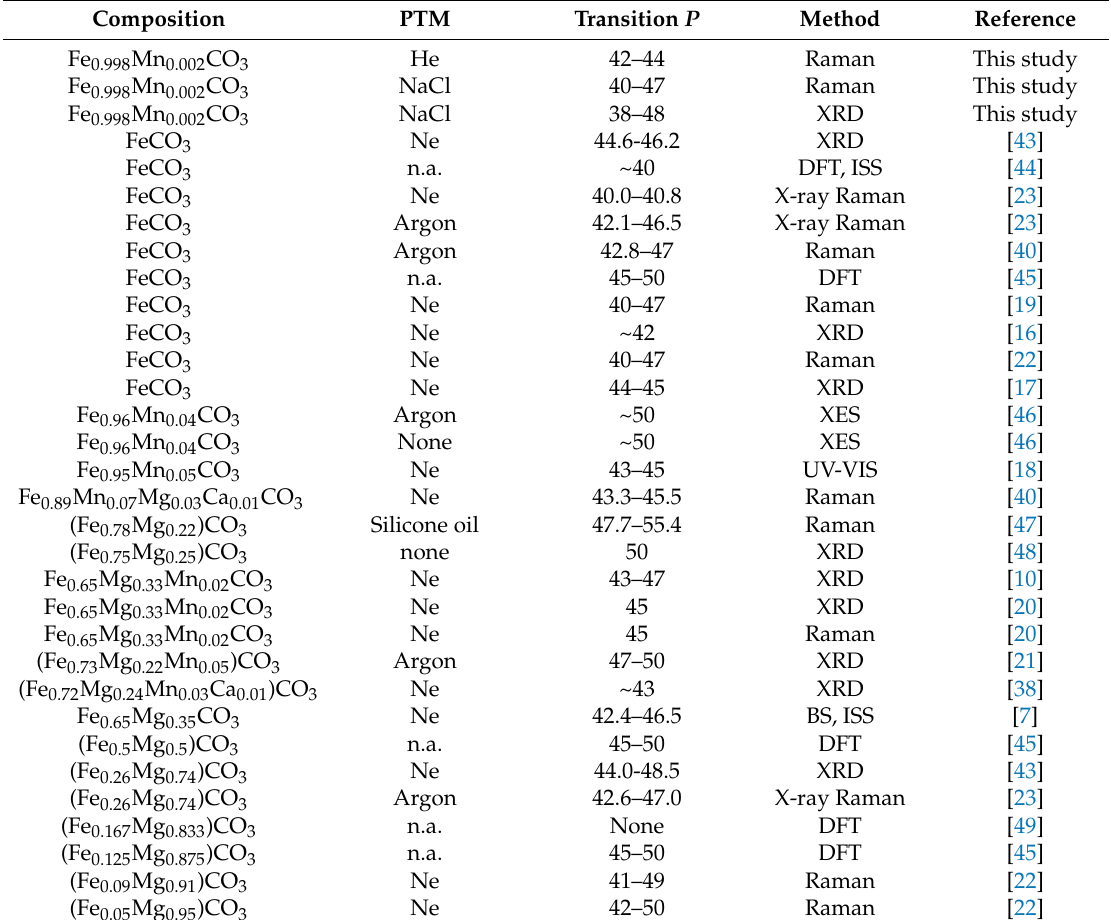
Table 1. Spin transition of (Mg,Fe)CO 3